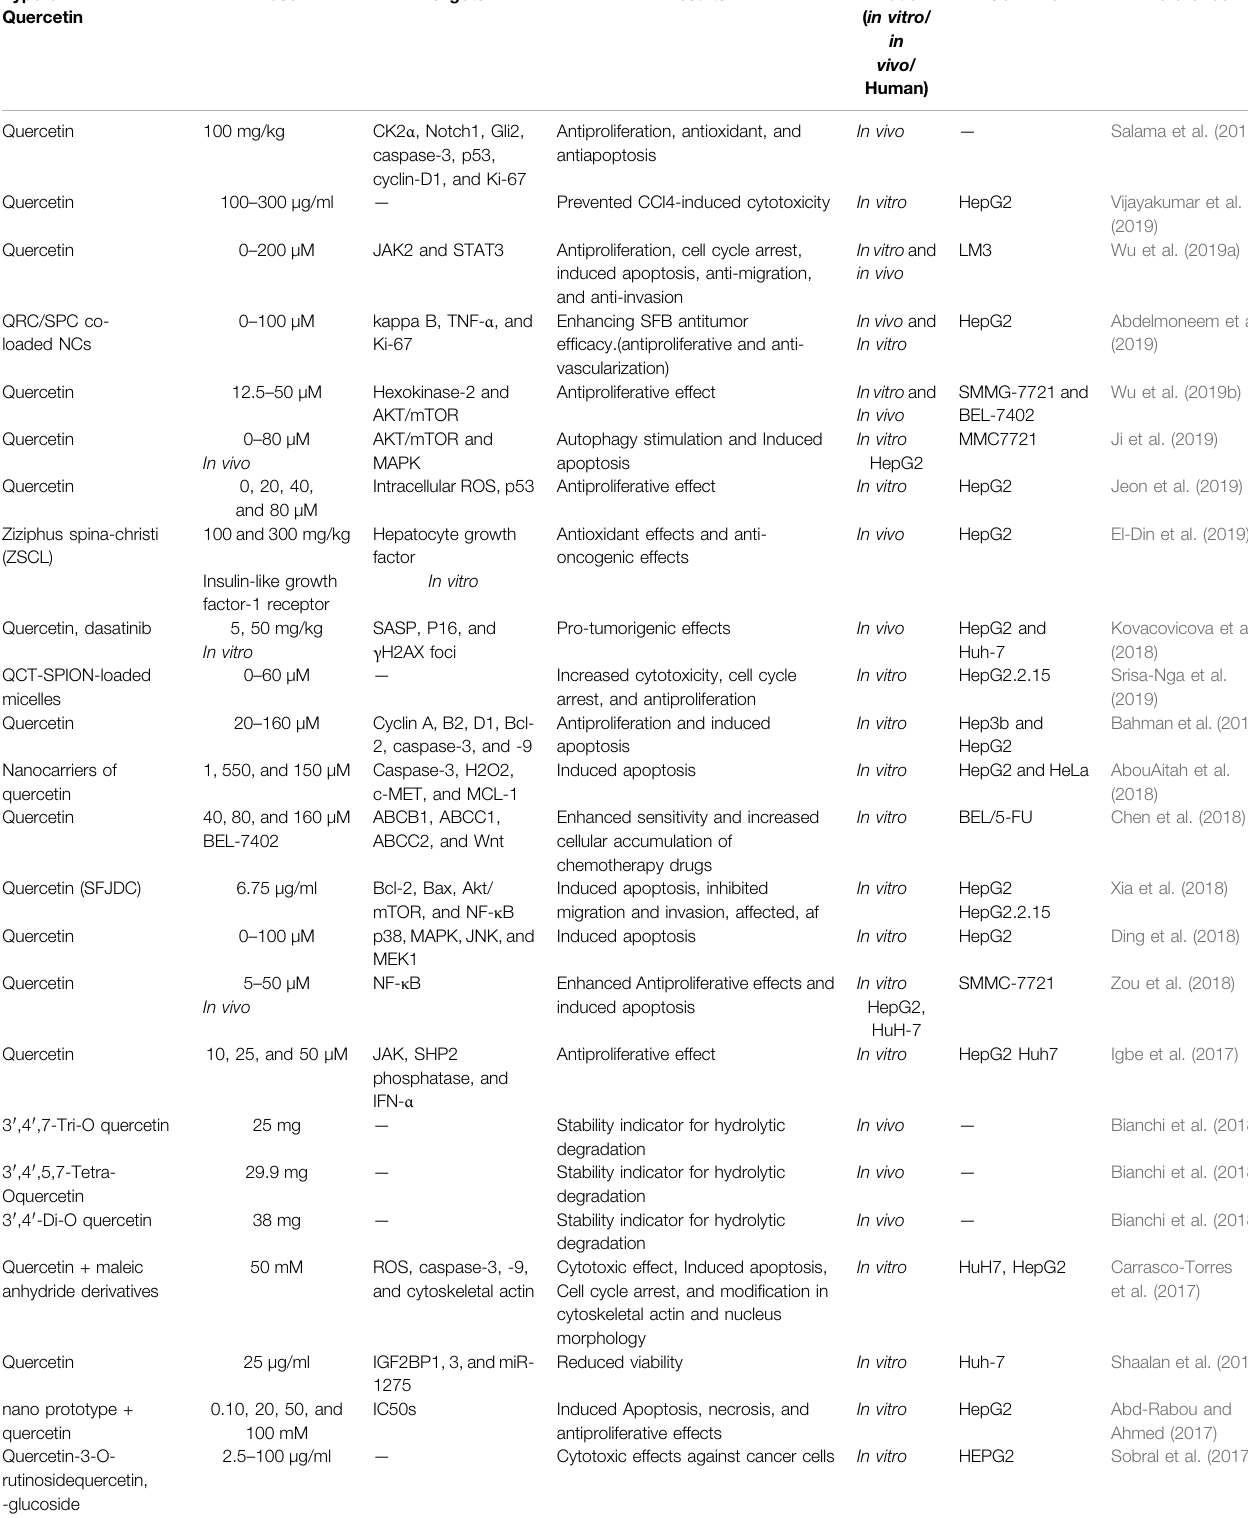
TABLE 5 | Studies on the therapeutic effects of quercetin in